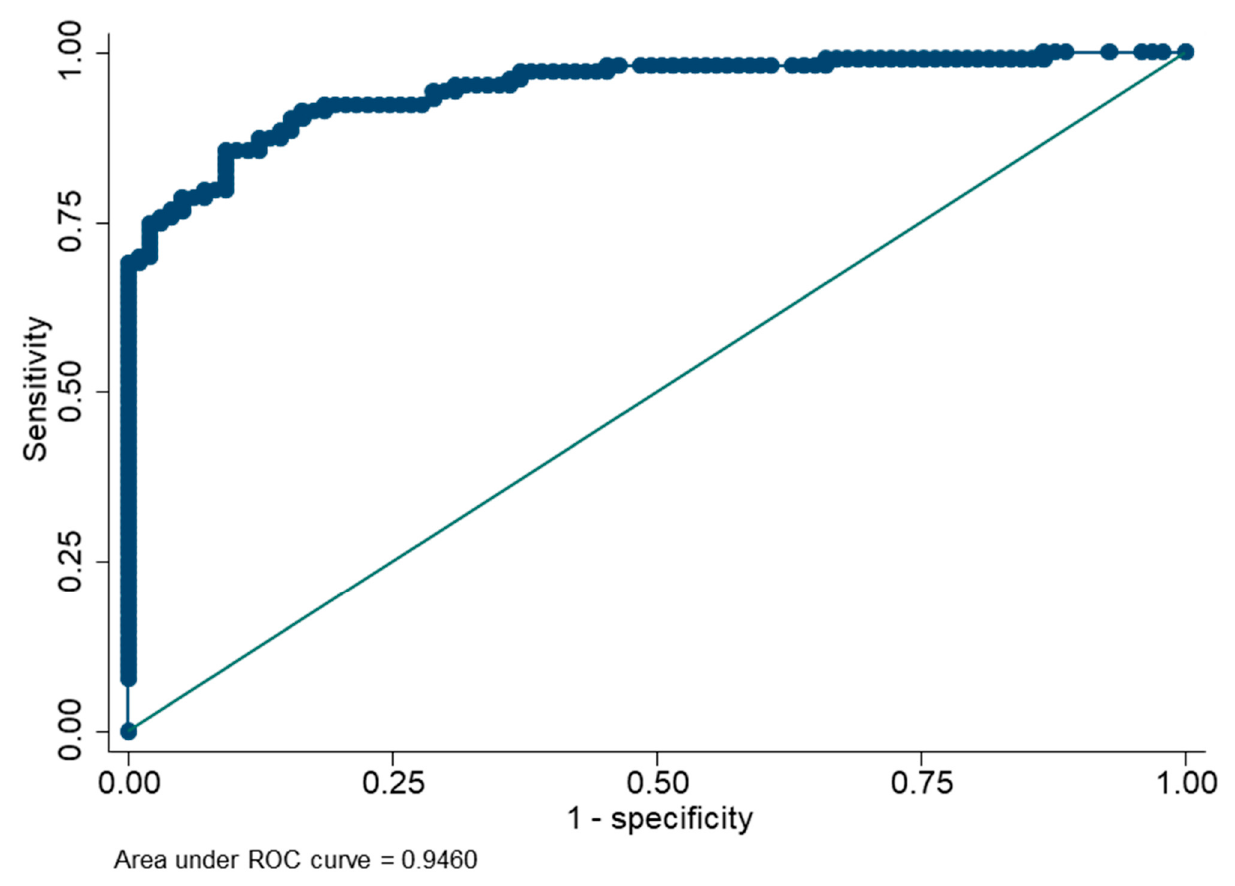
Figure 2. ROC analysis for ELISA results (OD/CO) from DBS compared to plasma, based on results from 200 paired DBS and plasma samples.